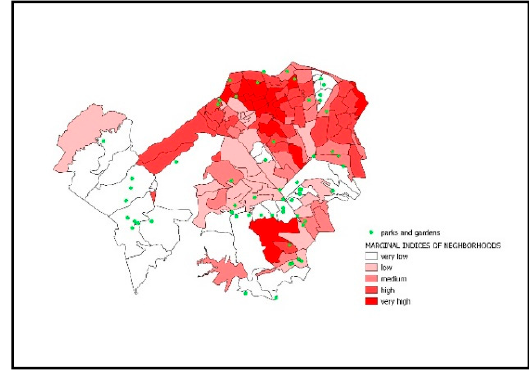
Figure 5. Marginalization index and public parks. (this figure is by authors, with data from Municiaplity of Atizapan and Conapo 2015 [44]).